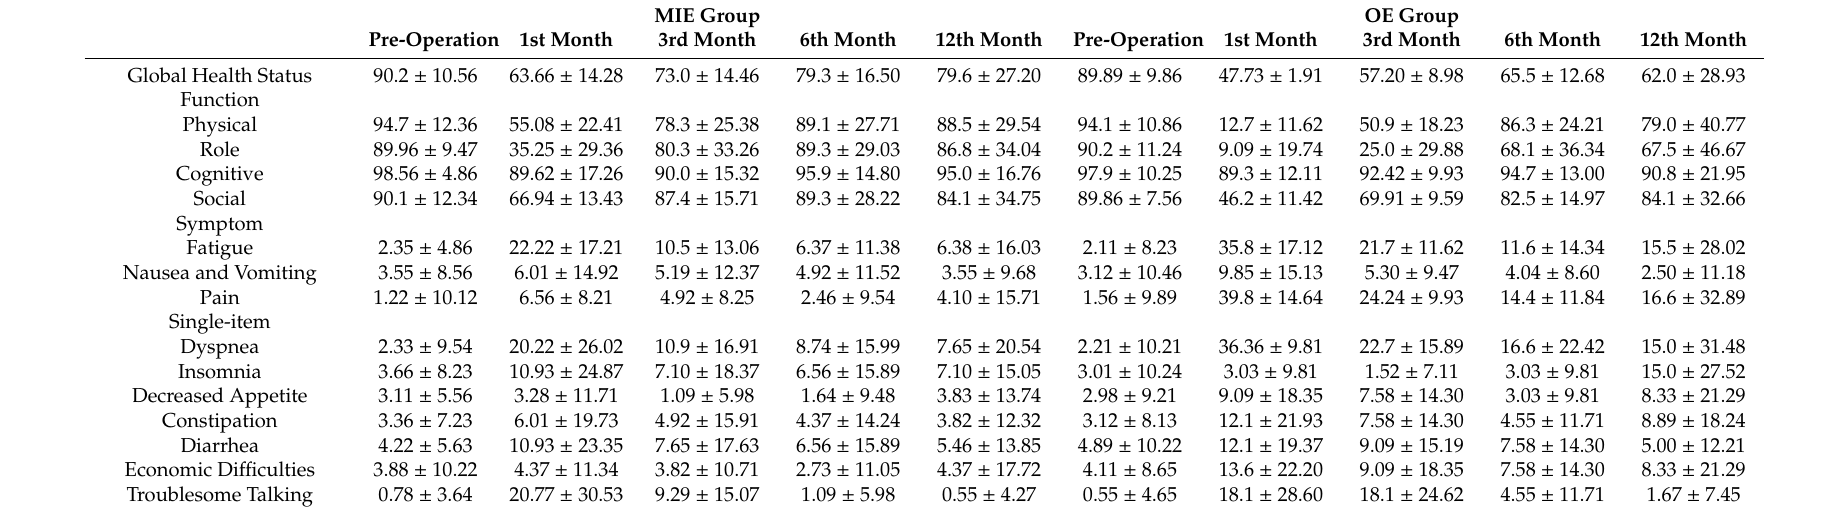
Table 3. The Comparison of QLQC-30 between the two groups.